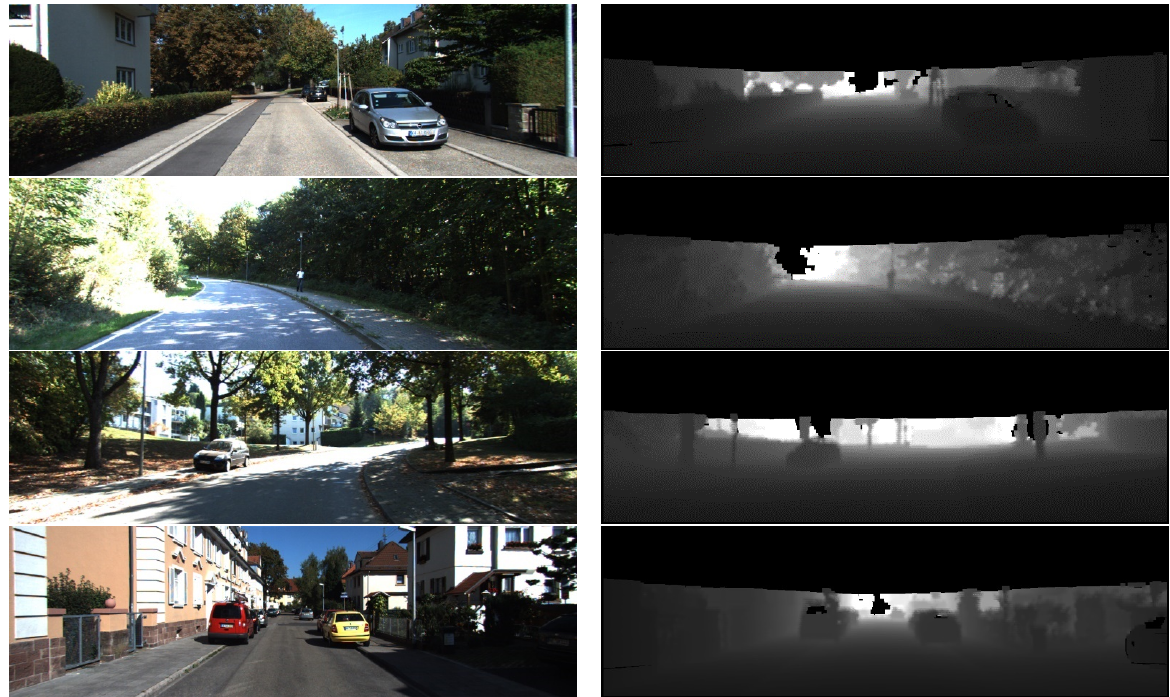
Figure 4. Comparison of raw images with density–depth